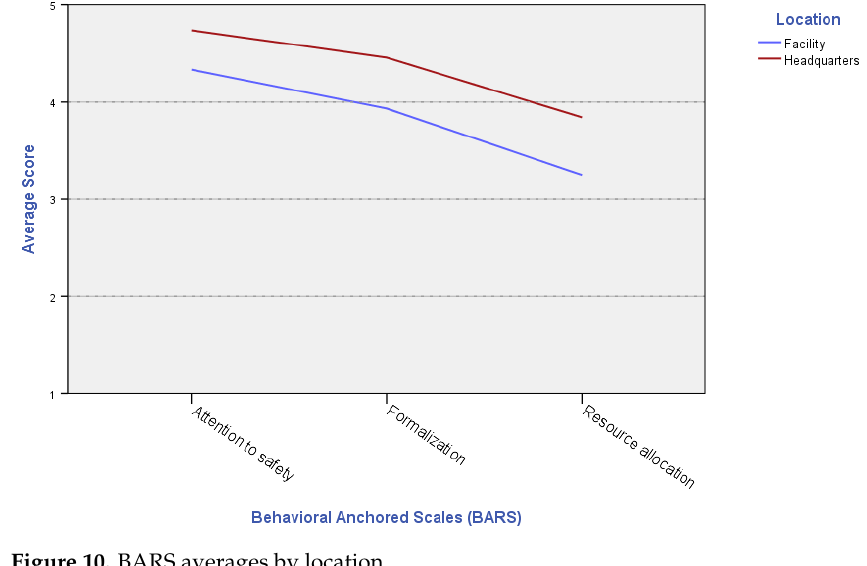
Figure 10. BARS averages by location.